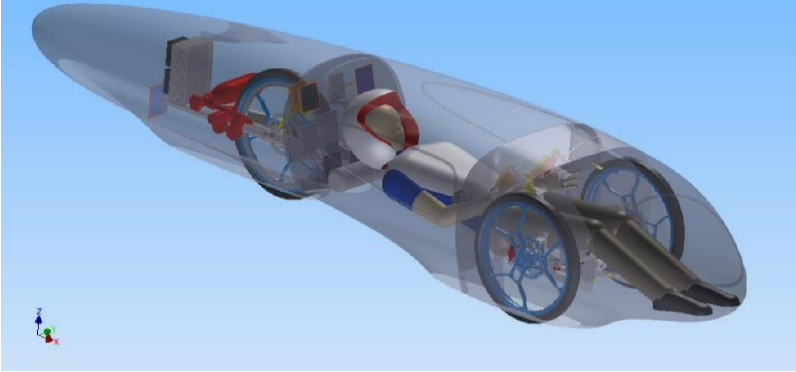
Figure 1. IDRAkronos’ layout.